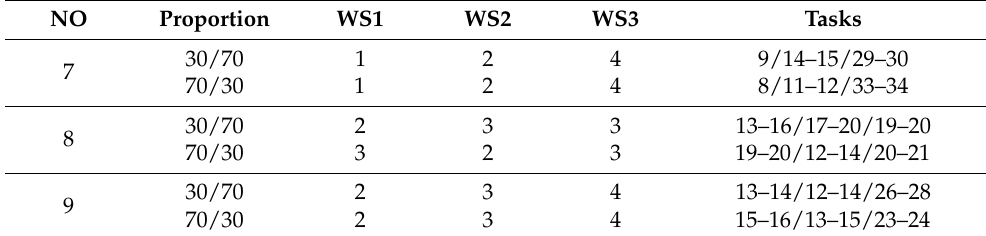
Table 2. Configurations and work task allocations.